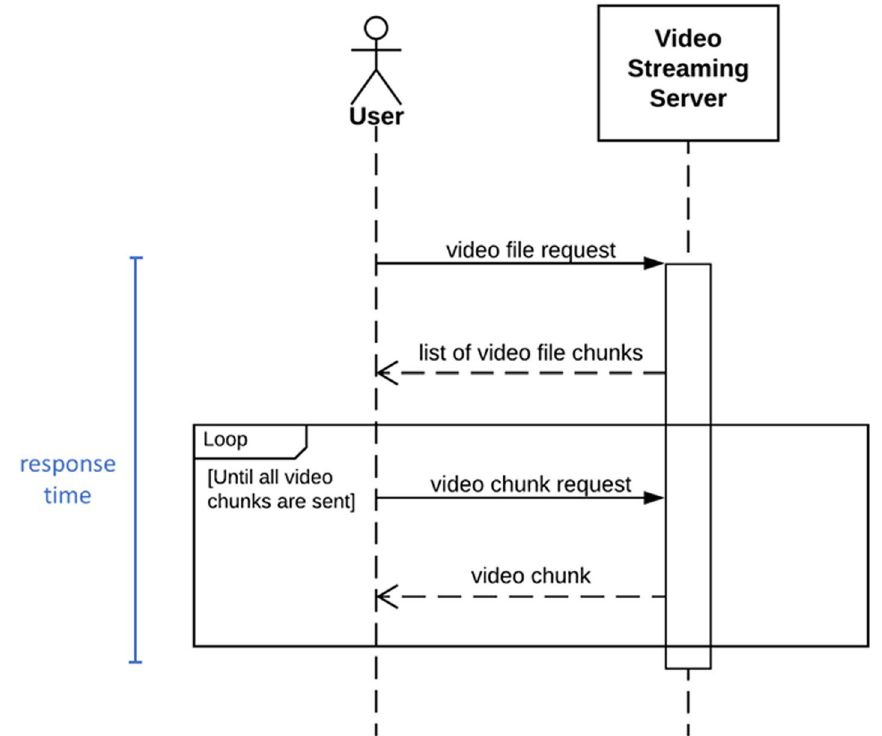
Fig. 7 UML sequence diagram of the video streaming use case scenario